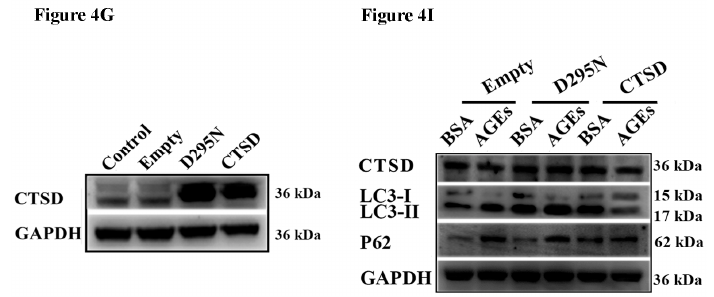
Figure A2. All the uncut western blotting bands in Figures 3 and 4. AGEs: advanced glycation end products; CTSD: cathepsin D